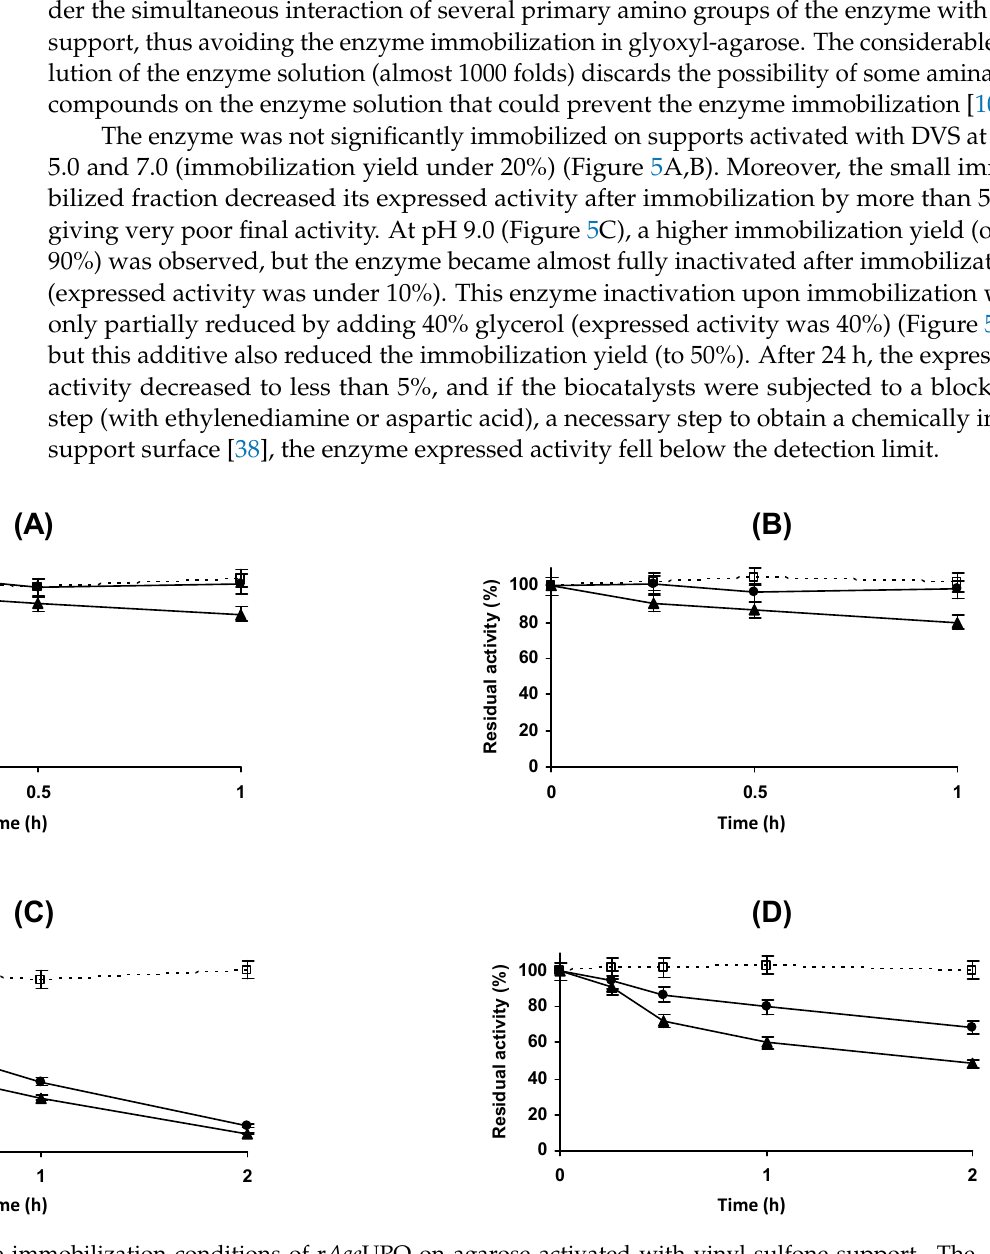
Figure 5. Effect of the immobilization conditions of r Aae UPO on agarose activated with vinyl sulfone support. The experiments were performed at 25 ◦ C in ( A ) 50 mM sodium acetate pH 5.0, ( B ) 50 mM sodium phosphate pH 7.0, ( C ) 50 mM sodium carbonate pH 9.0 and ( D ) 50 mM sodium carbonate pH 9.0 with 40% glycerol. Other specifications can be found in the Methods section. Full circles: suspension; full triangles: supernatant; empty squares with dotted line: reference.